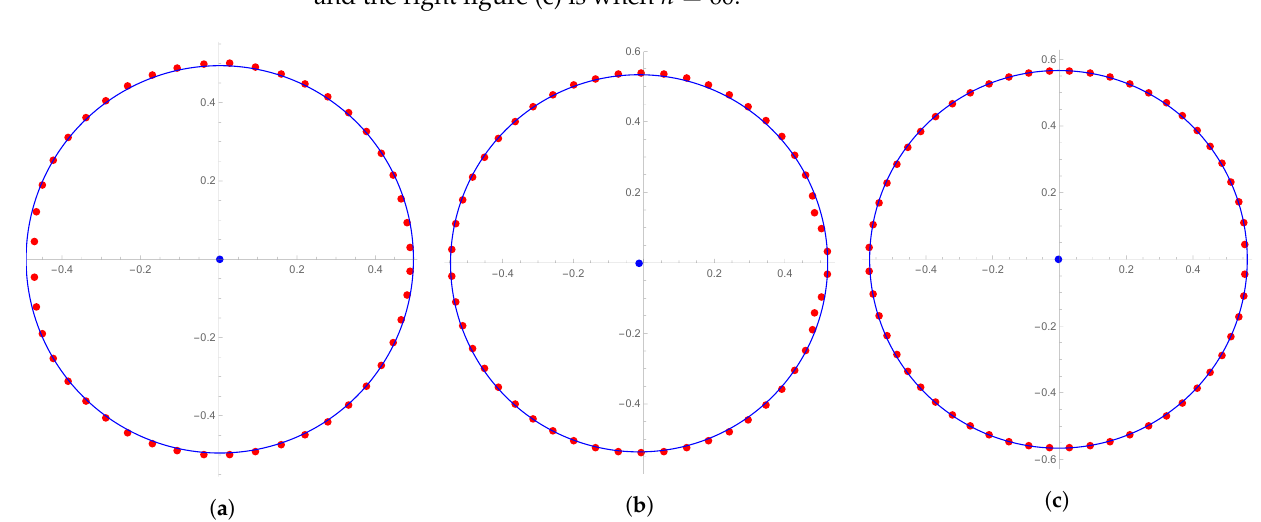
Figure 3. Approximate circles of zeros for C S n ,0.9,0.1 ( x ,2 ) for n = 50,55,60. ( a ) C S 50,0.9,0.1 ( x ,2 ) ; ( b ) C S 55,0.9,0.1 ( x ,2 ) ; ( c ) C S 60,0.9,0.1 ( x ,2 ) .